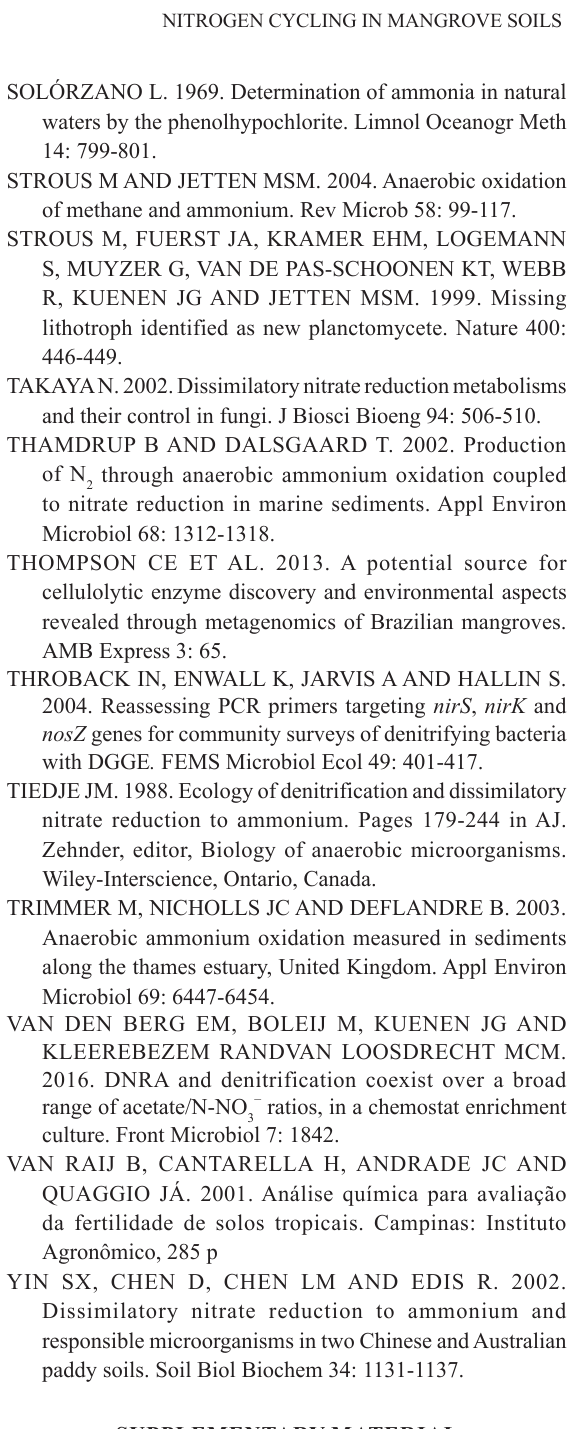
Table SI - Amounts of nitrite (in mg/L) in mangrove soil samples along the experiment. Table SII - Number of sequences affiliated to functional genes involved in the nitrogen transformations found in mangrove soils